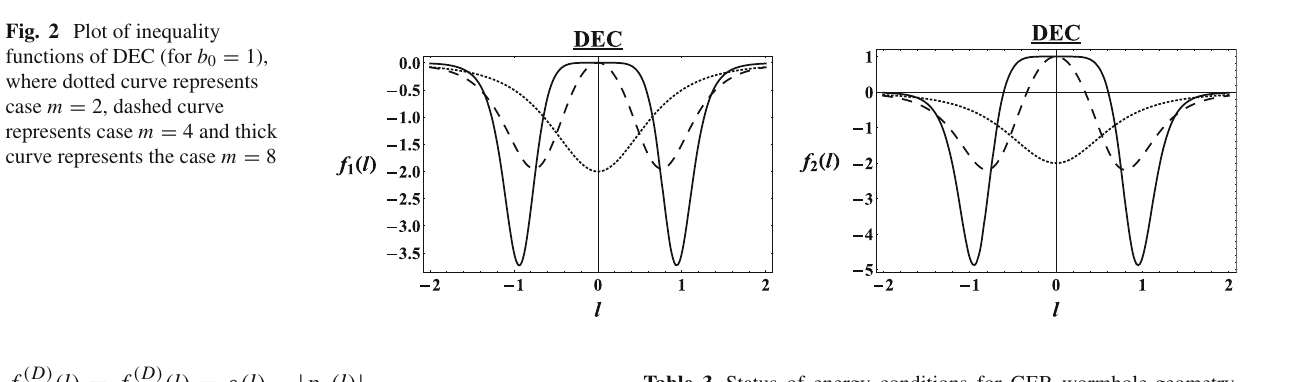
Table 3 Status of energy conditions for GEB wormhole-geometry, where ‘Yes’, ‘Y’ and ‘No’ stands for satisfied, partially satisfied and not satisfied respectively GEB m = 2 m > 2 Ineq.